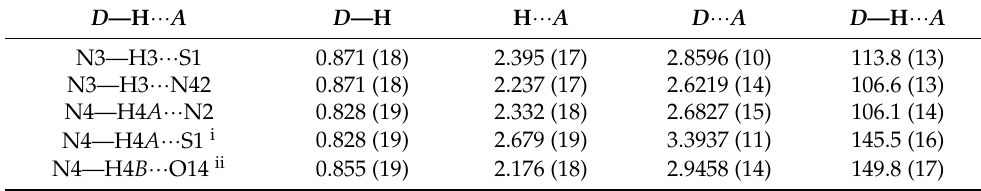
Table 8. Hydrogen-bond geometry (Å, ◦ ) for compound 6